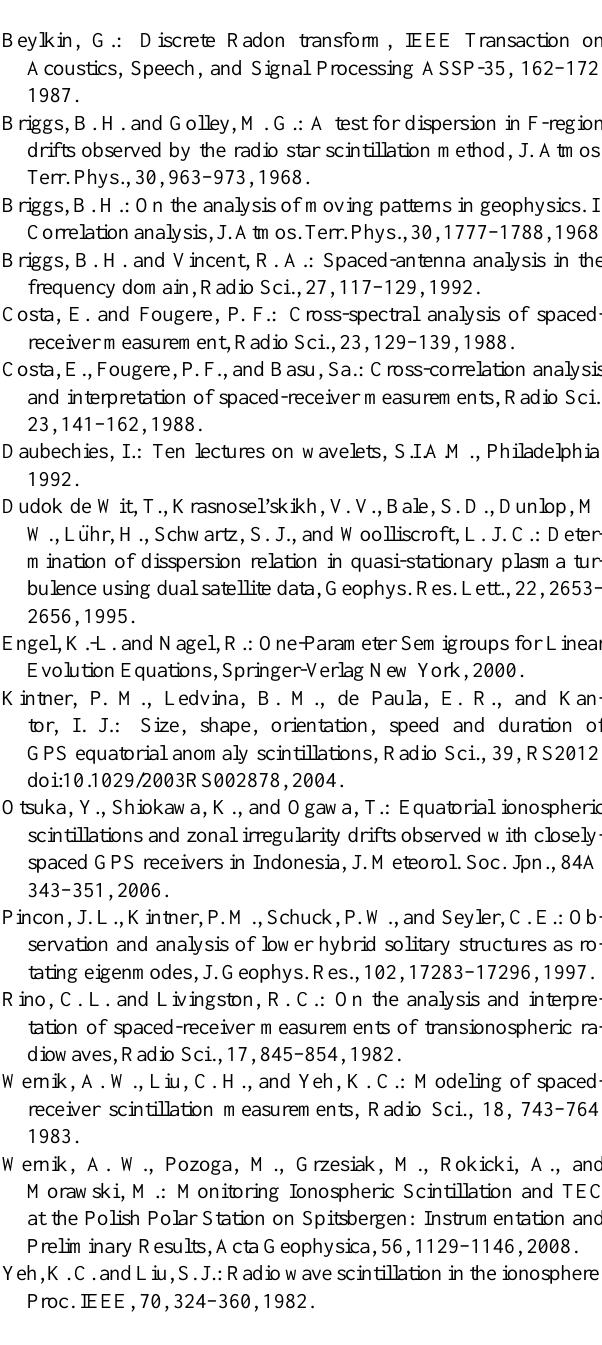
Table 1. Estimates of drift velocity parameters for points marked in Fig. 10.